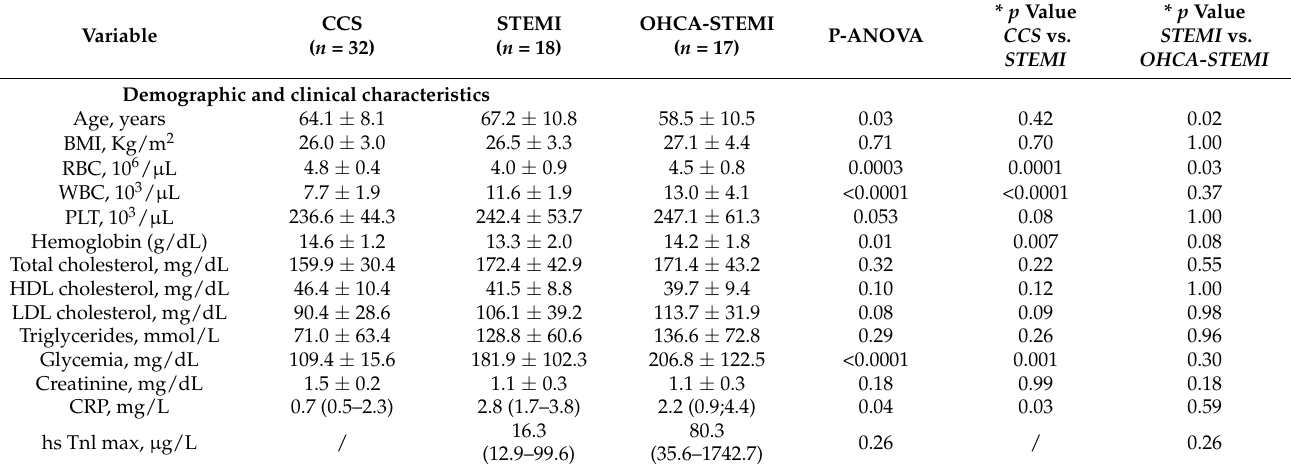
Table 1. Clinical and laboratory data of the study